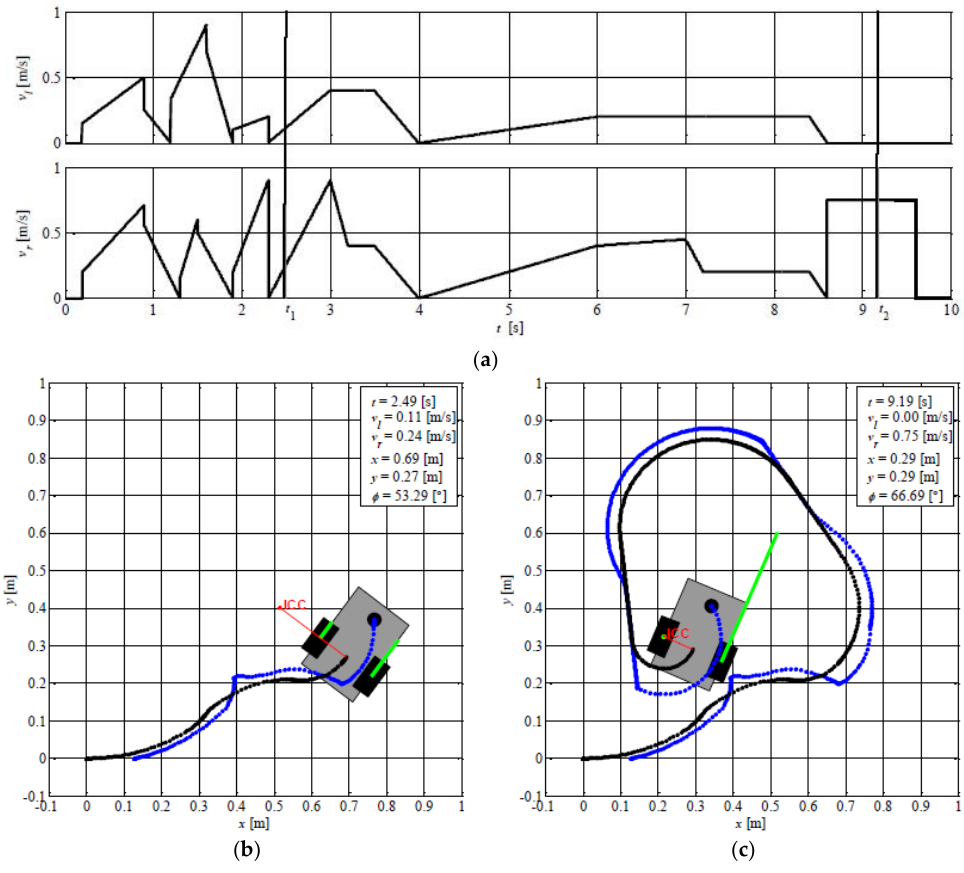
Figure 5. Simulation results of robot’s motion: ( a ) values of linear velocities vl and vr , ( b ) picture at t 1 time moment, ( c ) picture at t 2 time moment.